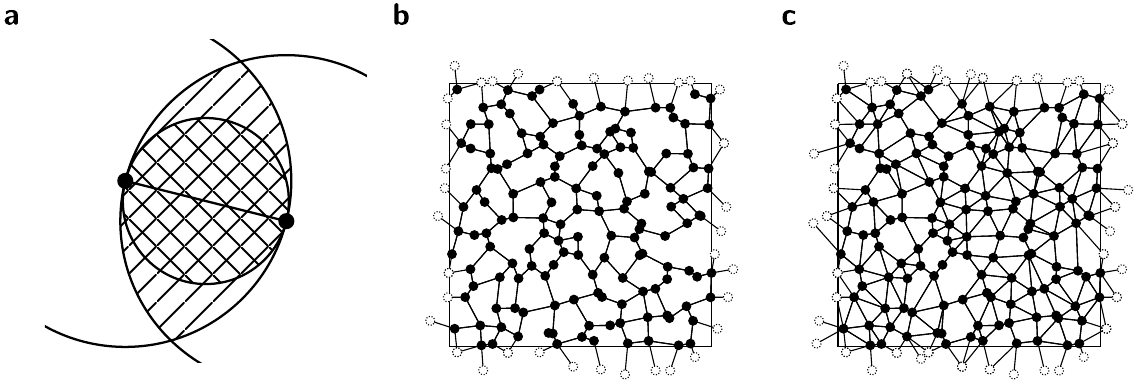
Figure 1. ( a ) Lunes of two nodes regarding the RNG (hatched region) and GG (cross hatched region), respectively. If there is no node located in the lune, both depicted nodes will be linked by an edge. ( b ) Example of the RNG with periodic boundary conditions. ( c ) Example of the GG with periodic boundary conditions. Mirror images of nodes (visualising the periodic boundary conditions) are shown in